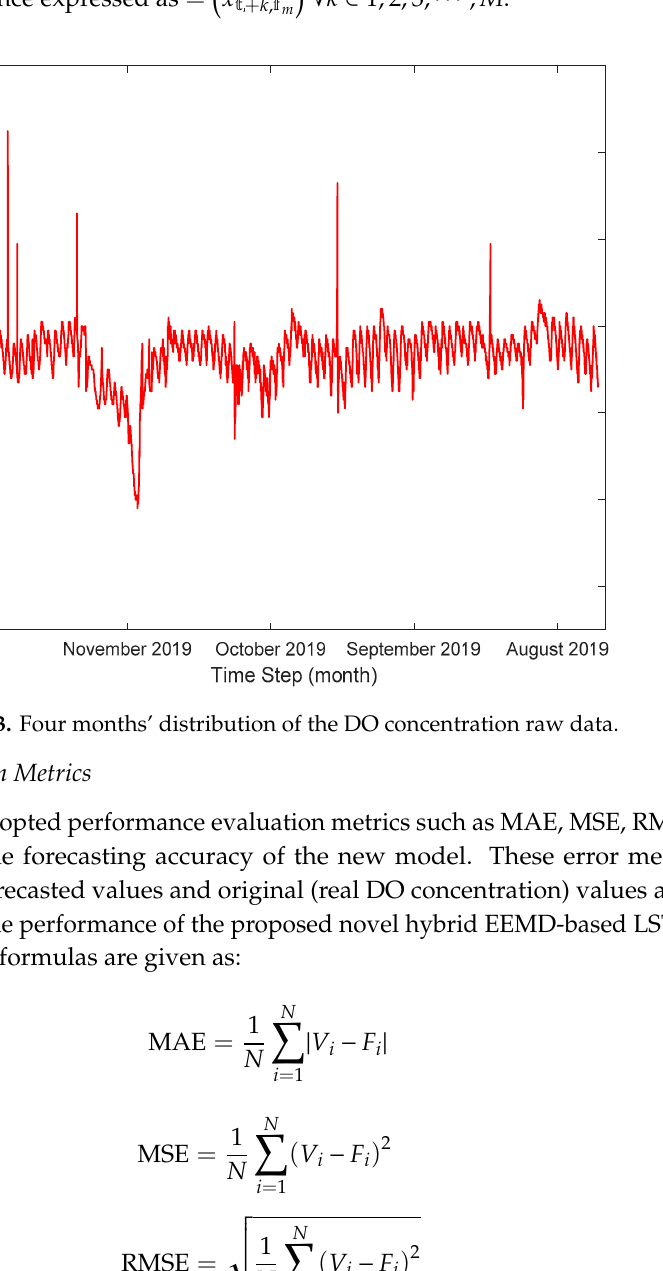
Figure 3. Four months’ distribution of the DO concentration raw data.